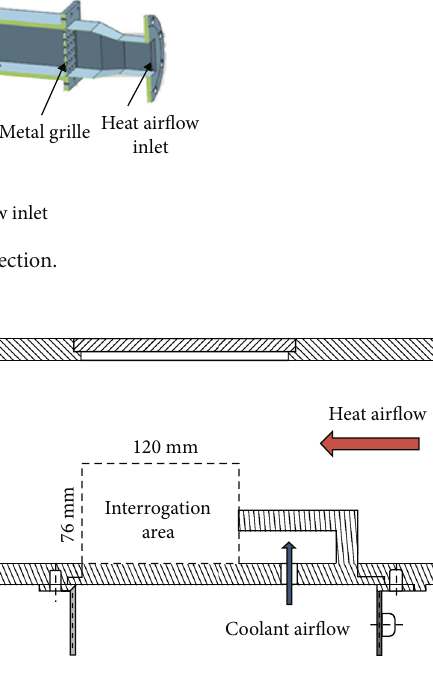
Figure 7: Schematic diagram of the interrogation area in the PIV experiment.